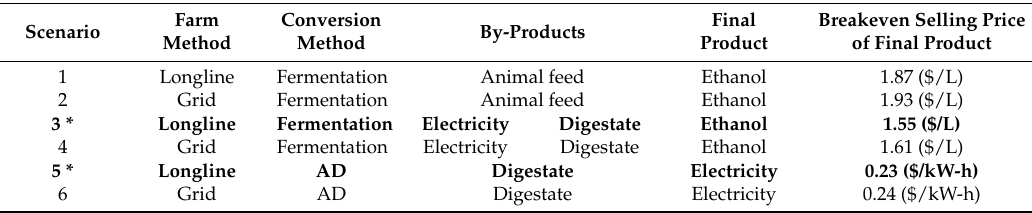
* Bold indicates the lowest breakeven price for the scenarios.